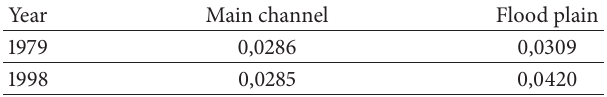
Table 2: Manning’s coefficient of friction.